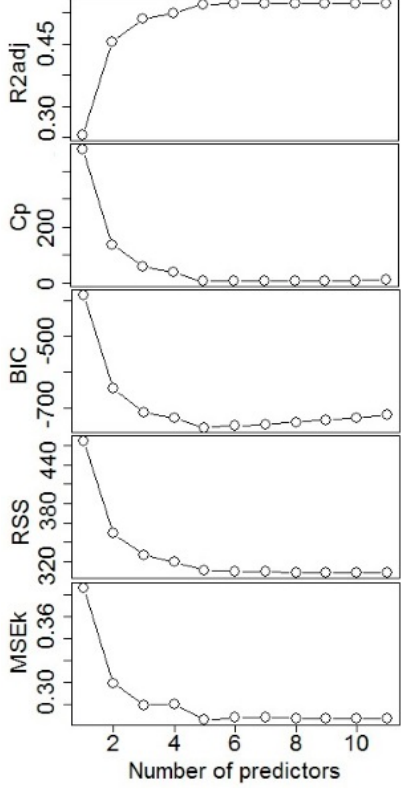
Figure 2. Goodness-of-fit statistics of adjusted r-squared (R 2 adj), Statistics Mallows’ C p , Schwartz’s information criterion (BIC), residual sum of squares (RSS), and the mean squared error averaged over the K folds (MSE K ) for different number of predictors with cross-validation (CV) regression selection model using the fitting database. Table 2. Parameter estimates of selected models for estimation of the logarithm of annual increment in diameter at breast height (AIDBH, mm year − 1 ) for cross-validation (CV) and least absolute shrinkage and selection operator (LASSO) procedures.